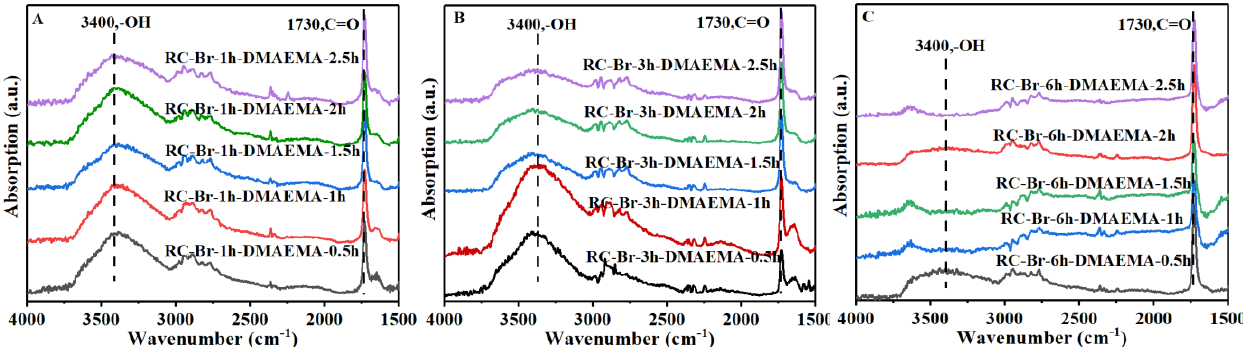
Figure 4. FTIR spectra of ( A ) RC-Br-1h ( B ) RC-Br-3h, and ( C ) RC-Br-6h modified by DMAEMA with different reaction times.